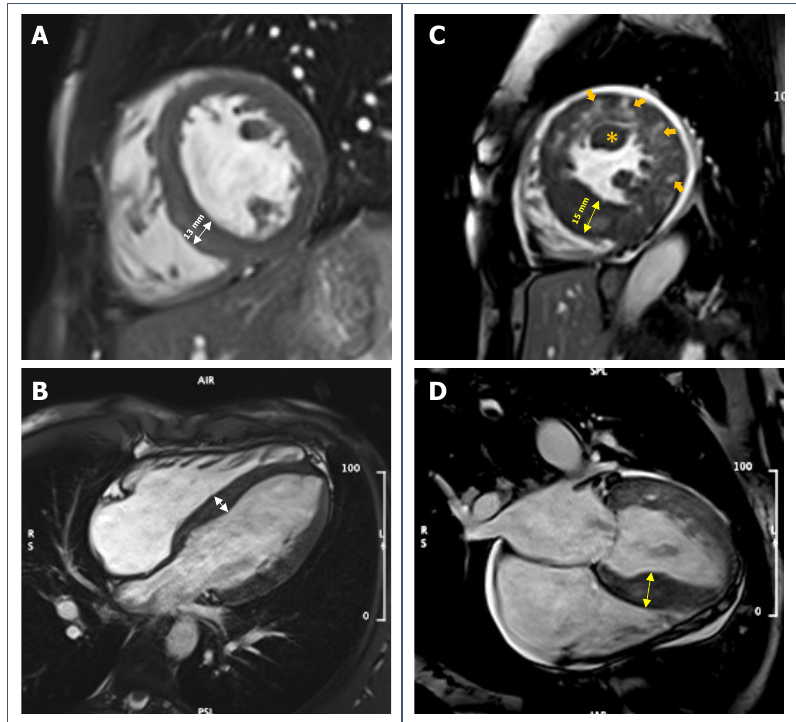
Figure 2. Left: short ‐ axis ( A ) and 4 ‐ chambers long ‐ axis ( B ) SSFP ‐ images of a 27 ‐ year ‐ old male competitive athlete with borderline LV symmetrical hypertrophy (13 mm, white arrows) in the context of mildly increased biventricular volumes and normal biventricular function and no other symptoms or signs of disease. Right: short ‐ axis ( C ) and 4 ‐ chambers long ‐ axis ( D ) SSFP ‐ images of a 32 ‐ year ‐ old male athlete with increased LV wall thickness especially on interventricular septum (15 mm, yellow arrows), relatively small LV cavity obliterating in systole, papillary muscle hypertrophy (orange asterisk); sequences have been acquired after gadolinium injection and inhomogeneous myocardial signal can be appreciated in these images (orange arrows). The athlete had been referred to CMR for ECG abnormalities.